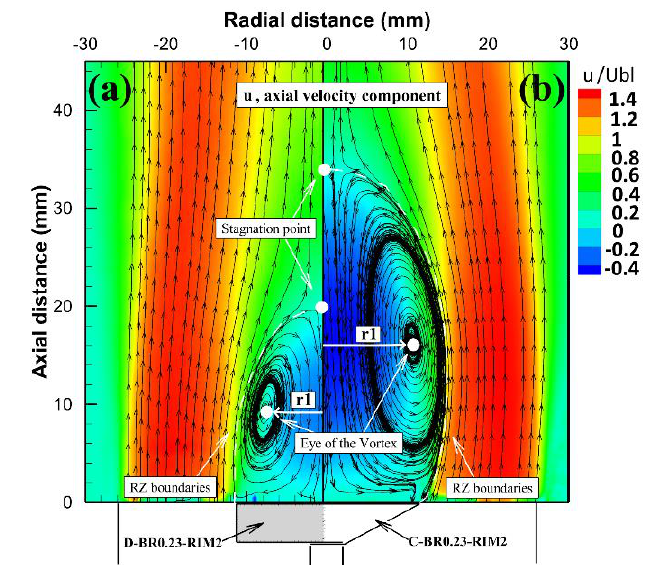
Figure 2. Structure of recirculation zone (RZ) and longitudinal velocity component disposition for ( a ) D-BR023-RIM2 and ( b ) C-BR0.23-RIM2 cases. The zero or stagnation streamline is also depicted by the white dashed line, which demonstrates the recirculation zone boundary. It extends from the rim edge of the baffle